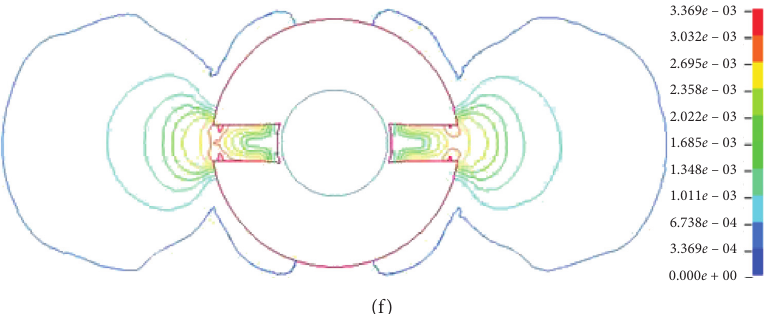
Figure 9: The pressure fluctuation process of numerical results. (a) 0.05 μ s, (b) 0.36 μ s, (c) 0.85 μ s, (d) 2.05 μ s, (e) 2.05 μ s, (f) 2.89 μ s, and (g) 4.85 μ